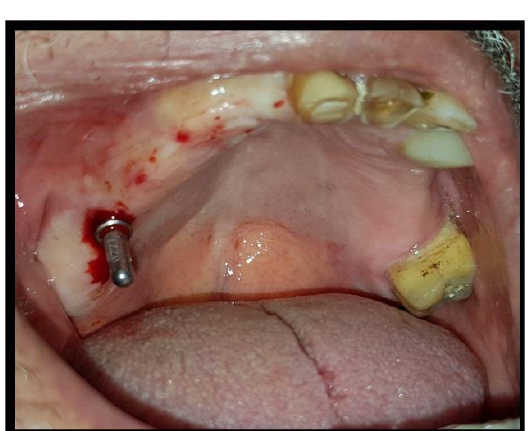
Figure 4: Parallel pin to verify proposed implant